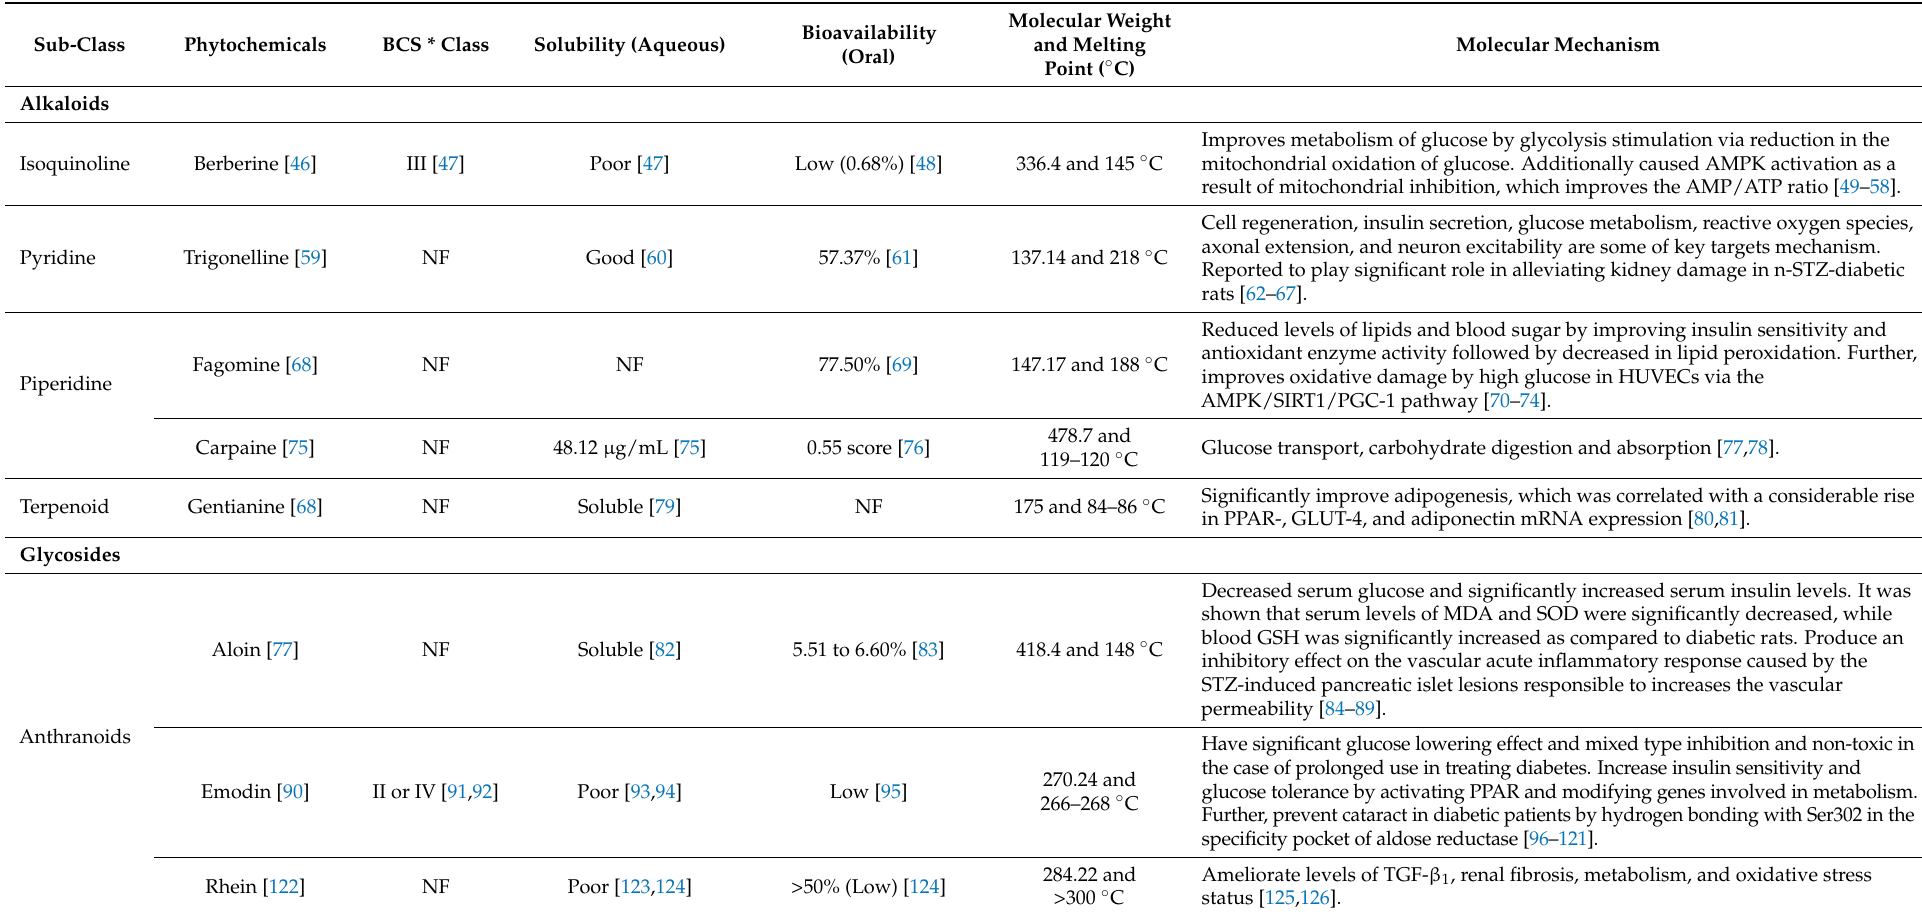
Table 1. Phytoconstituents exhibiting antihyperglycemic